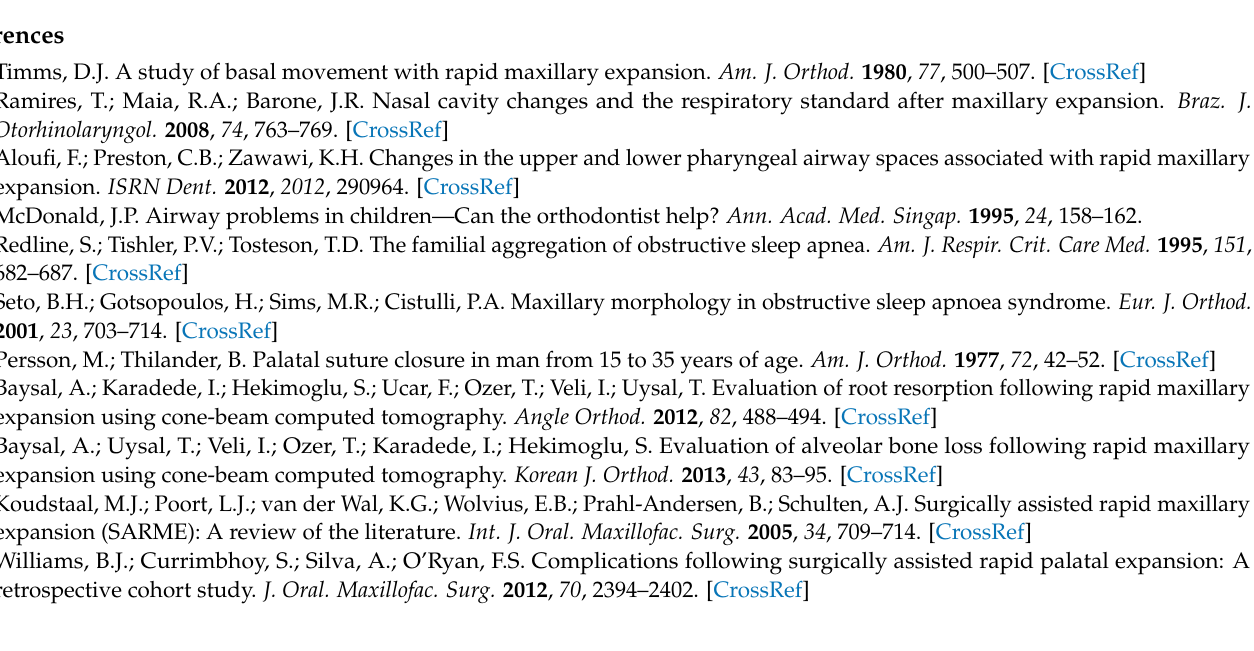
strategy; Table S2: Search results by database; Table S3: Studies excluded at full-text review with Table S5: The main in-formation of the CBCT or CT analysis in this systematic review [30–42]; Table S6: Summary of findings table according to the GRADE approach; Table S7: Results of meta-analysis of all includ-ed studies; Table S8: Egger’s test was used to test the publication bias of the included studies; Table S9: Sensitivity analysis for the changes of upper airway volume after expansion and retention [32,34,35,37–42]; Figure S1: Results of the risk of bias assessment in the individual studies the Re-vised Cochrane Risk of Bias Tool for randomized trials (ROB2)